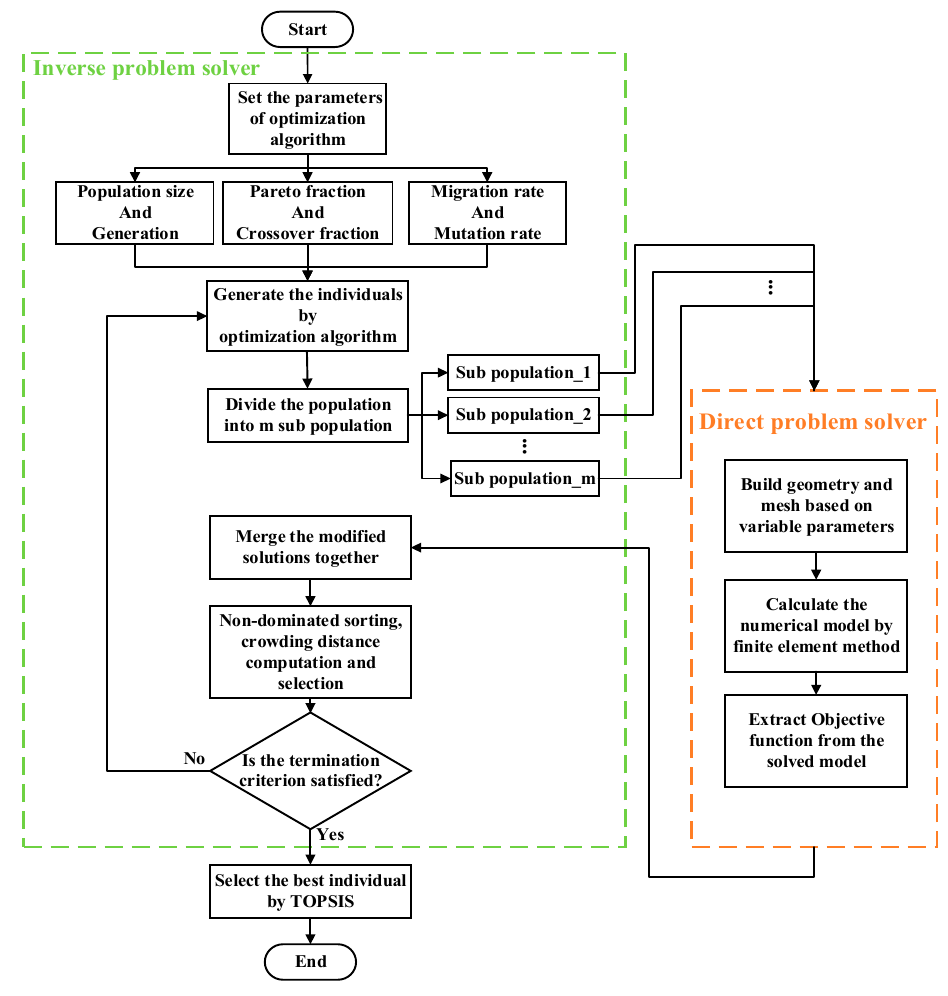
Figure 2. Flowchart of the optimization procedure.